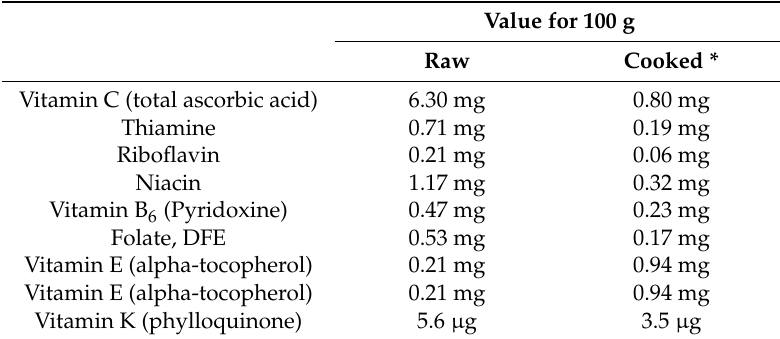
Table 7. Vitamins content of raw and cooked pinto beans.